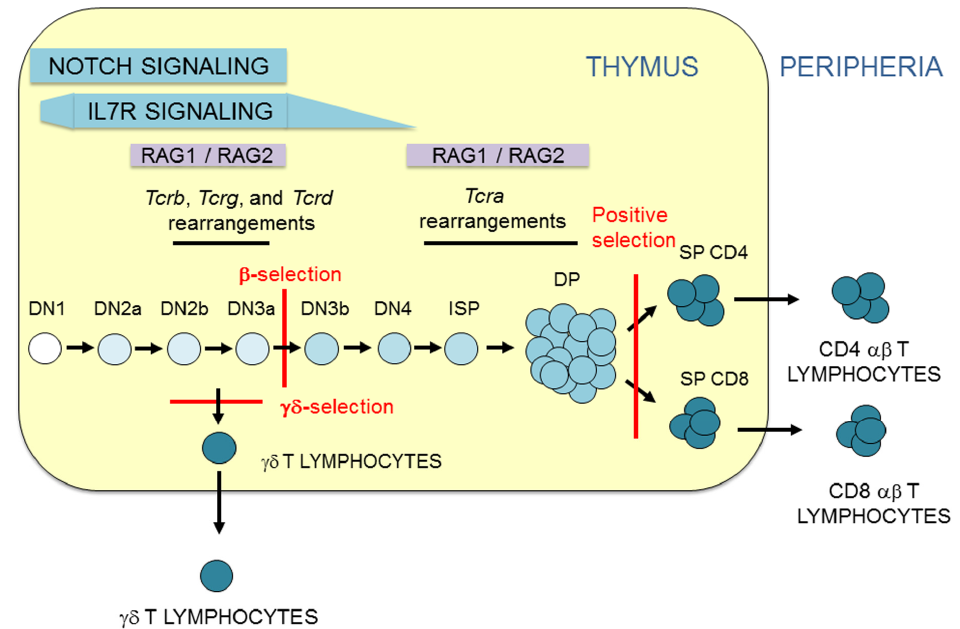
Figure 2. T lymphocyte development. Representation of T-cell maturation depicting the thymocyte stages and T-cell receptor (TCR) gene rearrangement. Thymus is represented as a yellow rectangle. Thymocyte and T lymphocyte populations are indicated. β -selection, γδ -selection, and positive selection are represented by red lines. The magnitude of Notch and interleukin 7 receptor (IL-7R) signaling is indicated. The two waves of recombination activating gene (RAG) proteins, RAG1 and RAG2, expression are indicated.